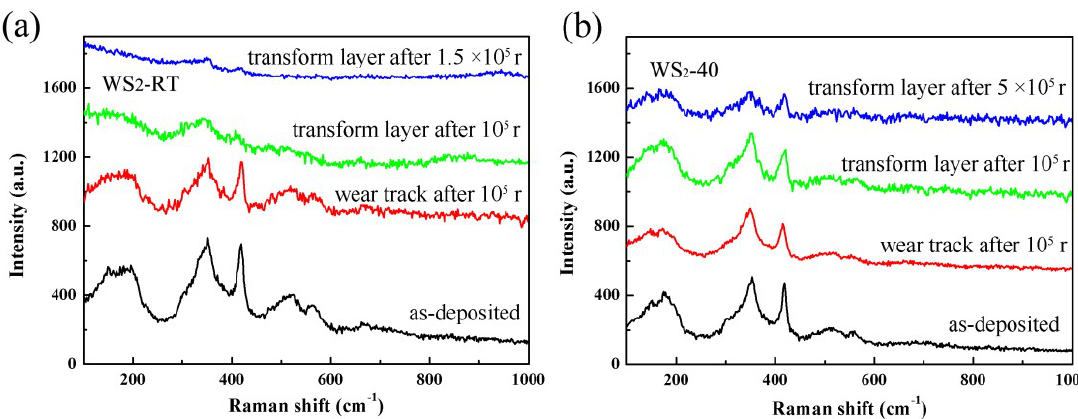
Figure 7. Raman spectra of the as-deposited film, wear track and transform layer on counterpart ball after1.0 × 10 5 sliding cycles as well as after film failure or 5.0 × 10 5 sliding cycles for ( a ) WS 2 -RT and ( b ) WS 2 -40 films.